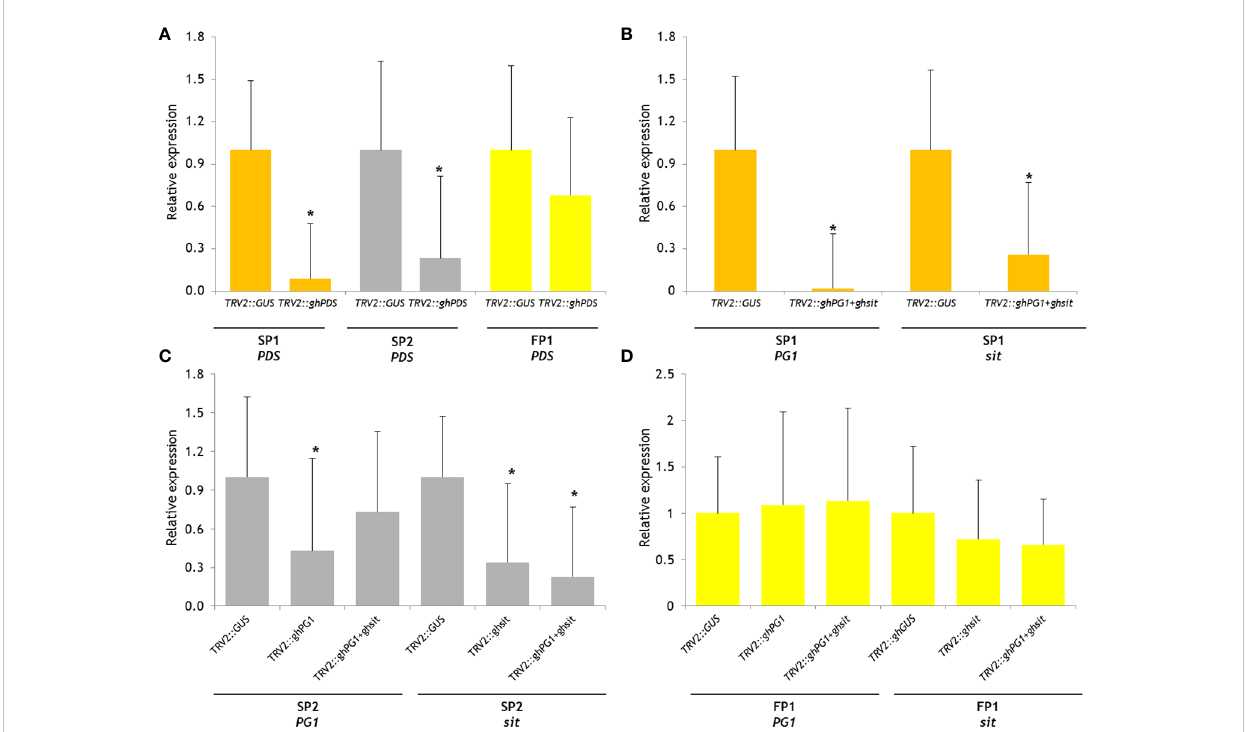
FIGURE 2 Relative gene expression level of reporter gene PDS and CGs in silenced plants using 2 - DD CT method. The change in expression of target gene in silenced plant which was normalized to reference gene (GAPDH) relative to control plant (as 1, TRV2::GUS plant in this experiment) and represented as fold change. The aster indicate signi fi cant difference compared with gene expression on control TRV2:: GUS plants (P<0.05). (A) Relative PDS expression on three parental TRV2::ghPDS silenced plants; (B) relative PG1 and sit expression on SP1 TRV2::GUS silenced plants and TRV2:: ghPG1+ghsit silenced plants; (C) relative PG1 expression on SP2 TRV2::GUS silenced plants, TRV2::ghPG1 silenced plants and TRV2::ghPG1 + ghsit silenced plants; relative sit expression on SP2 TRV2::GUS silenced plants, TRV2::ghsit silenced plants and TRV2::ghPG1 + ghsit silenced plants;